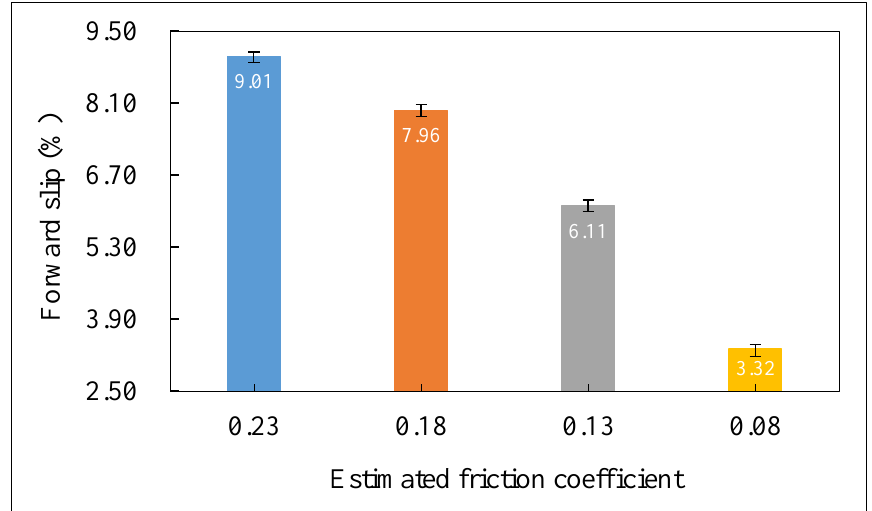
Figure 10. Dependence of forward slip on estimated friction coefficient for the rolling phase with thicker thickness.